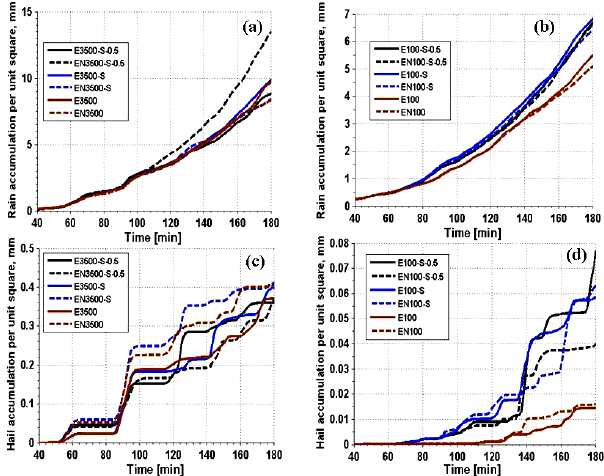
Figure 10. Time dependencies of accumulated rain at the surface for polluted (a) and for clean (b) air. Accumulated hail at the surface for polluted (c) and for clean (d) air in different simulations in polluted